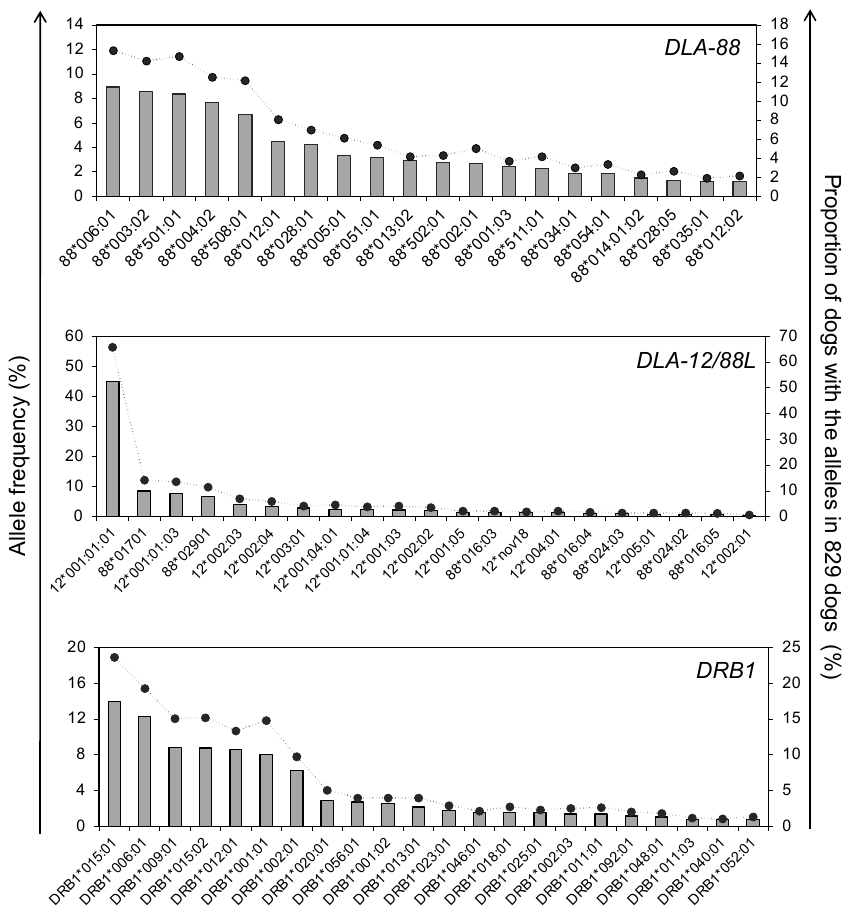
Figure 2. Top 20, 21 or 22 most frequent alleles of DLA-88 , DLA-12/88L and DLA-DRB1 loci detected for 829 dogs. The allele frequency and the proportion of dogs with each allele are described by a bar and line chart, respectively. The allele names are indicated below each graph.